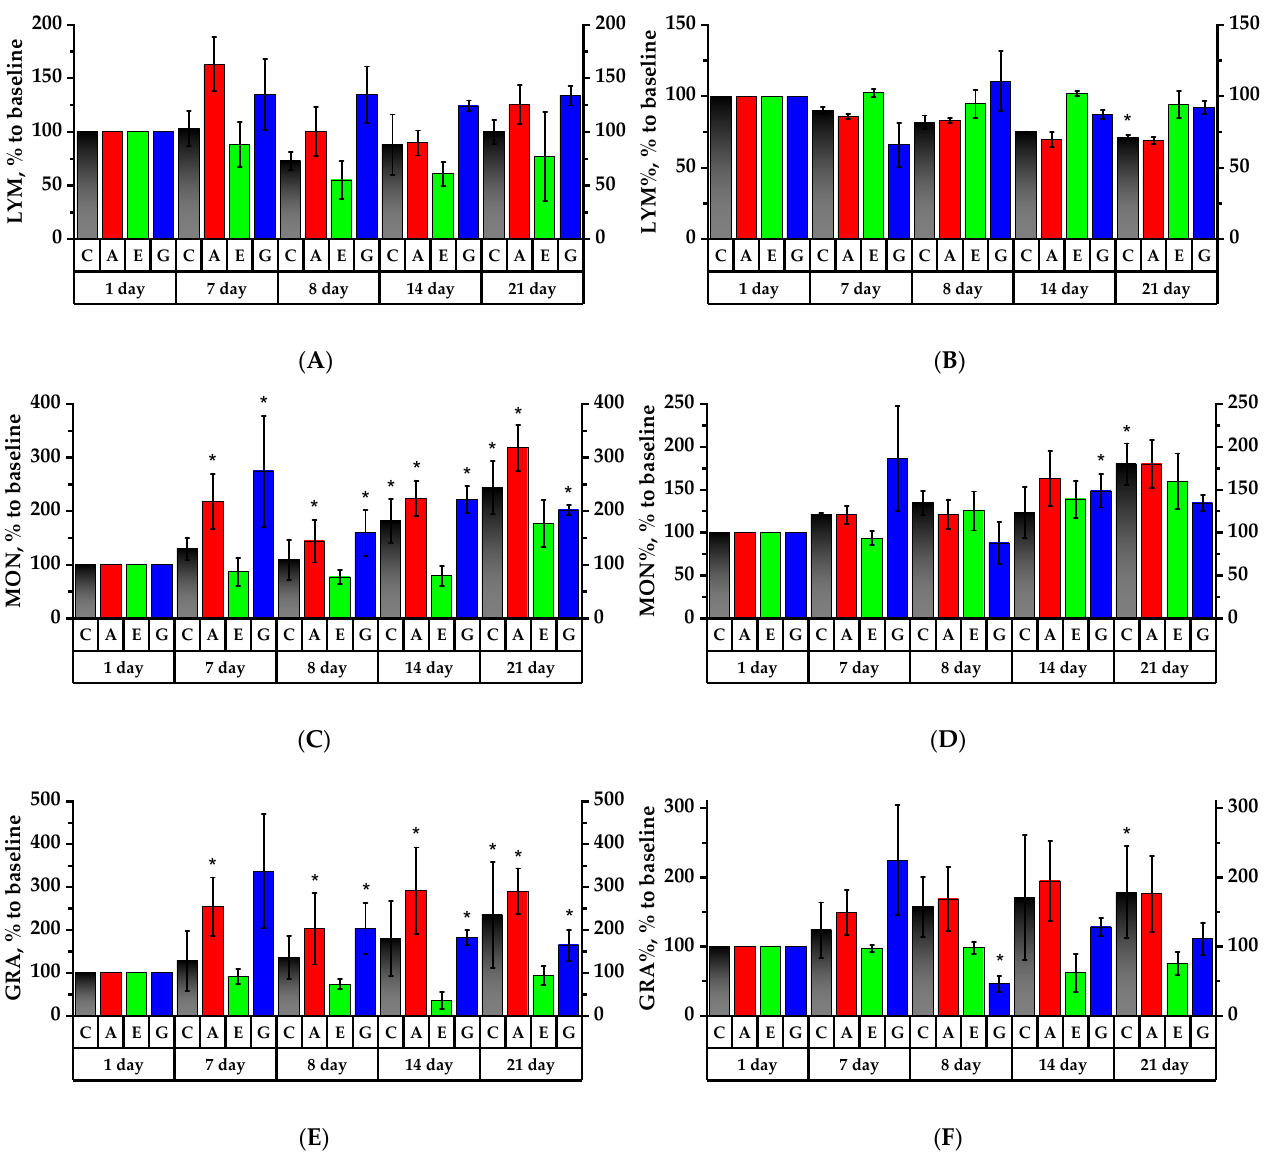
Figure 5. Leukocyte profile. The corresponding initial values for each group in the 1st day of the experiment are accepted as 100%. ( A ) Lymphocyte (LYM) count; ( B ) ratio of lymphocytes to total leukocytes (LYM%); ( C ) monocyte (MON) count; ( D ) ratio of monocytes to total leukocytes (MON%); ( E ) neutrophil granulocyte (GRA) count; ( F ) ratio of granulocytes to total leukocytes (GRA%). * p < 0.05, significance of differences in animal groups compared to the 1st day of the ex- periment.